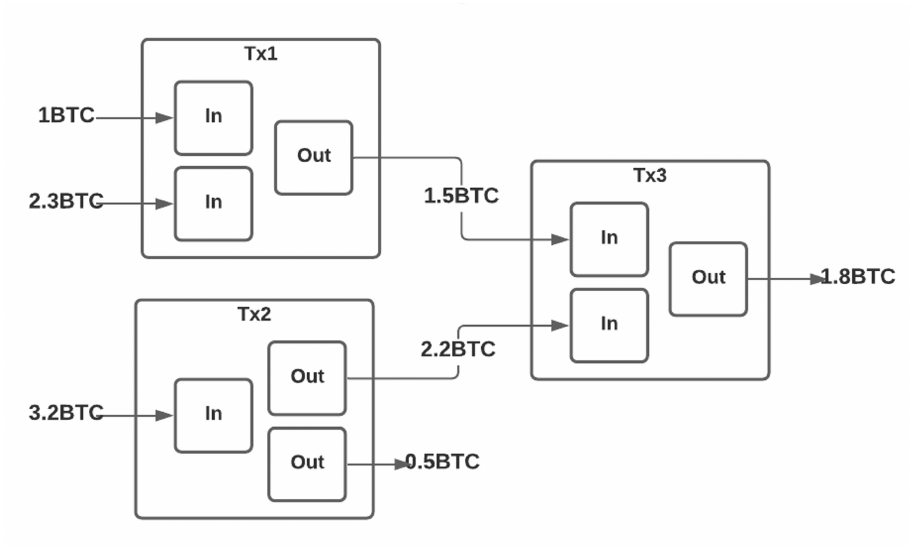
Figure 3. Concept of Unspent Transaction Outputs